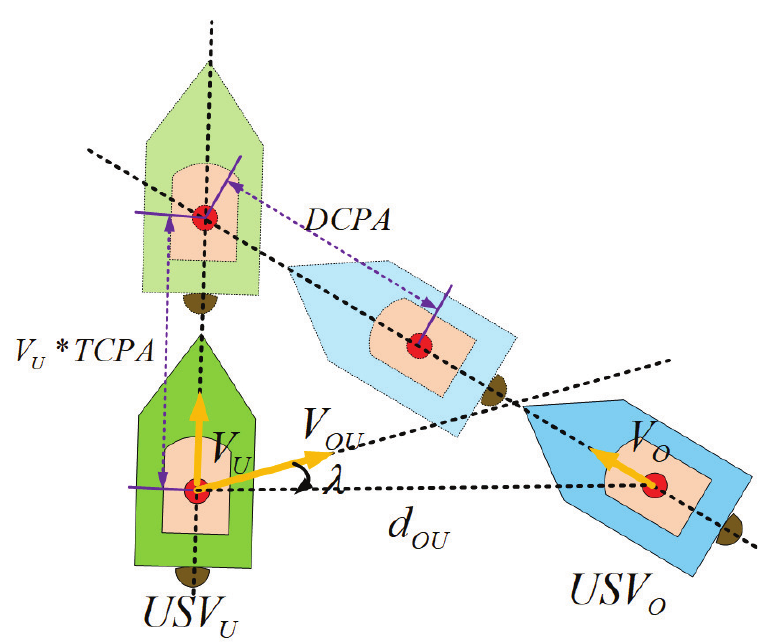
Figure 3. DCPA and